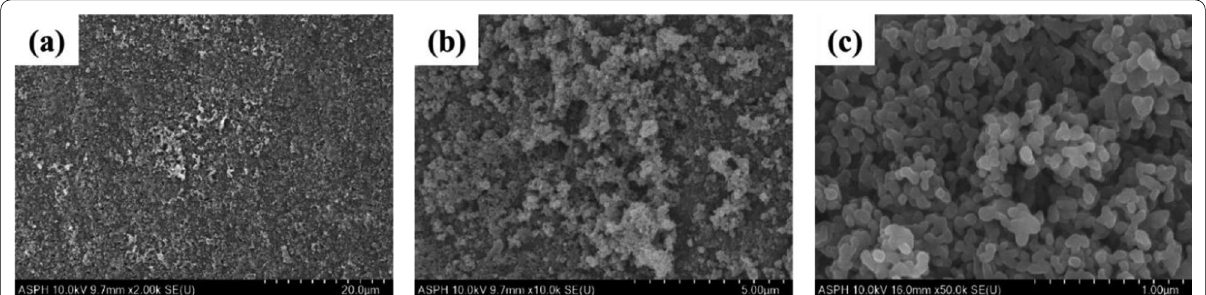
Fig. 6 FE‑SEM images of the surface of a Ti–6Al–4V ELI alloy mini‑screw of the APH group. a 2 k 50